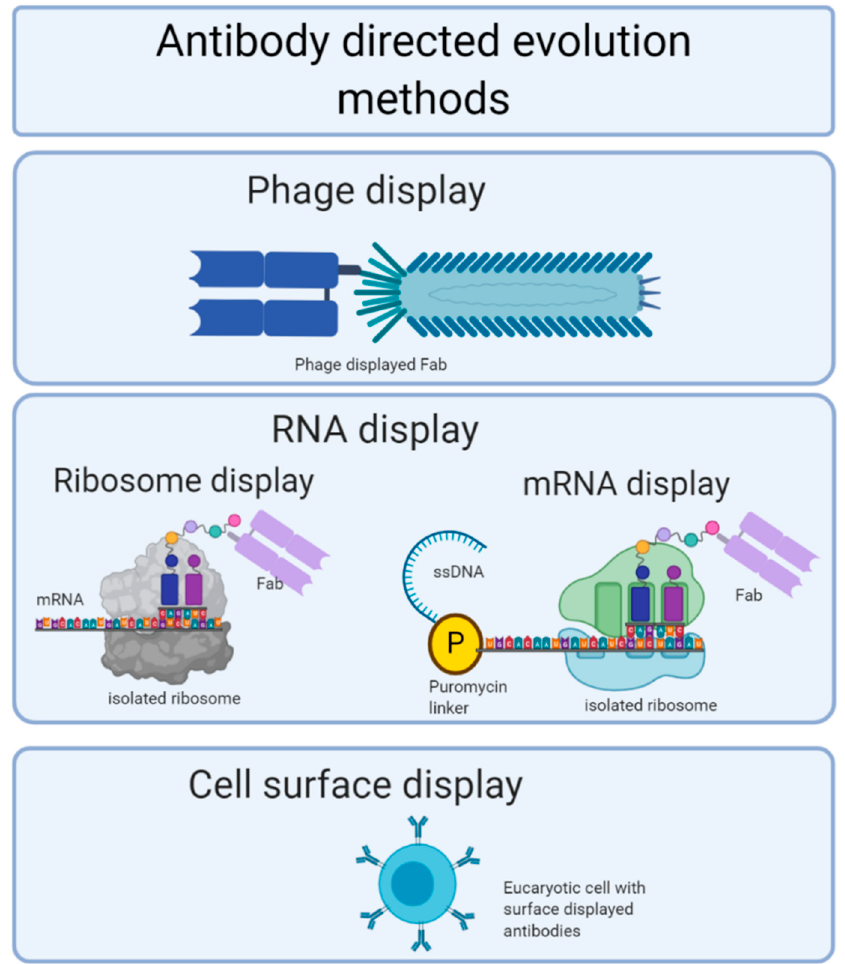
Figure 5. Schematic representation of antibody-directed evolution methods.